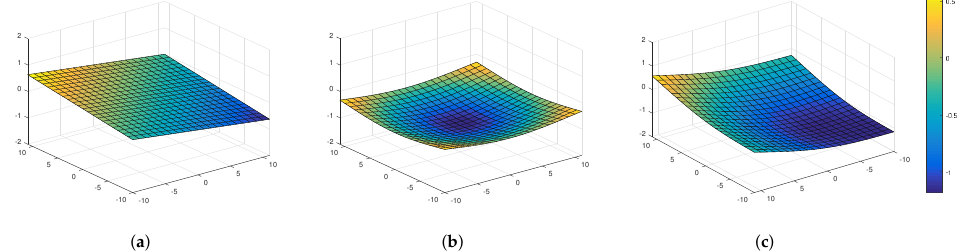
Figure 4. Representation of the surface of a tilted IC ( a ), a curved IC ( b ) and both ( c